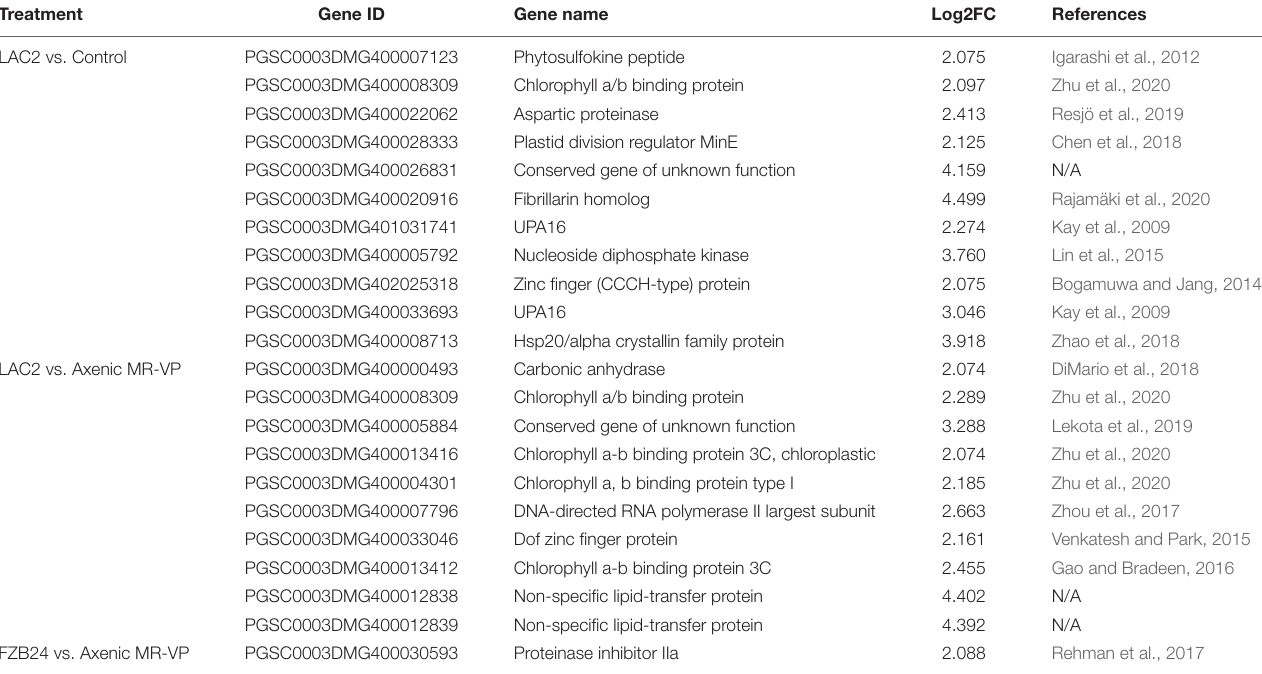
TABLE 2 | Upregulated genes from PGSC genome annotations in response to BVC